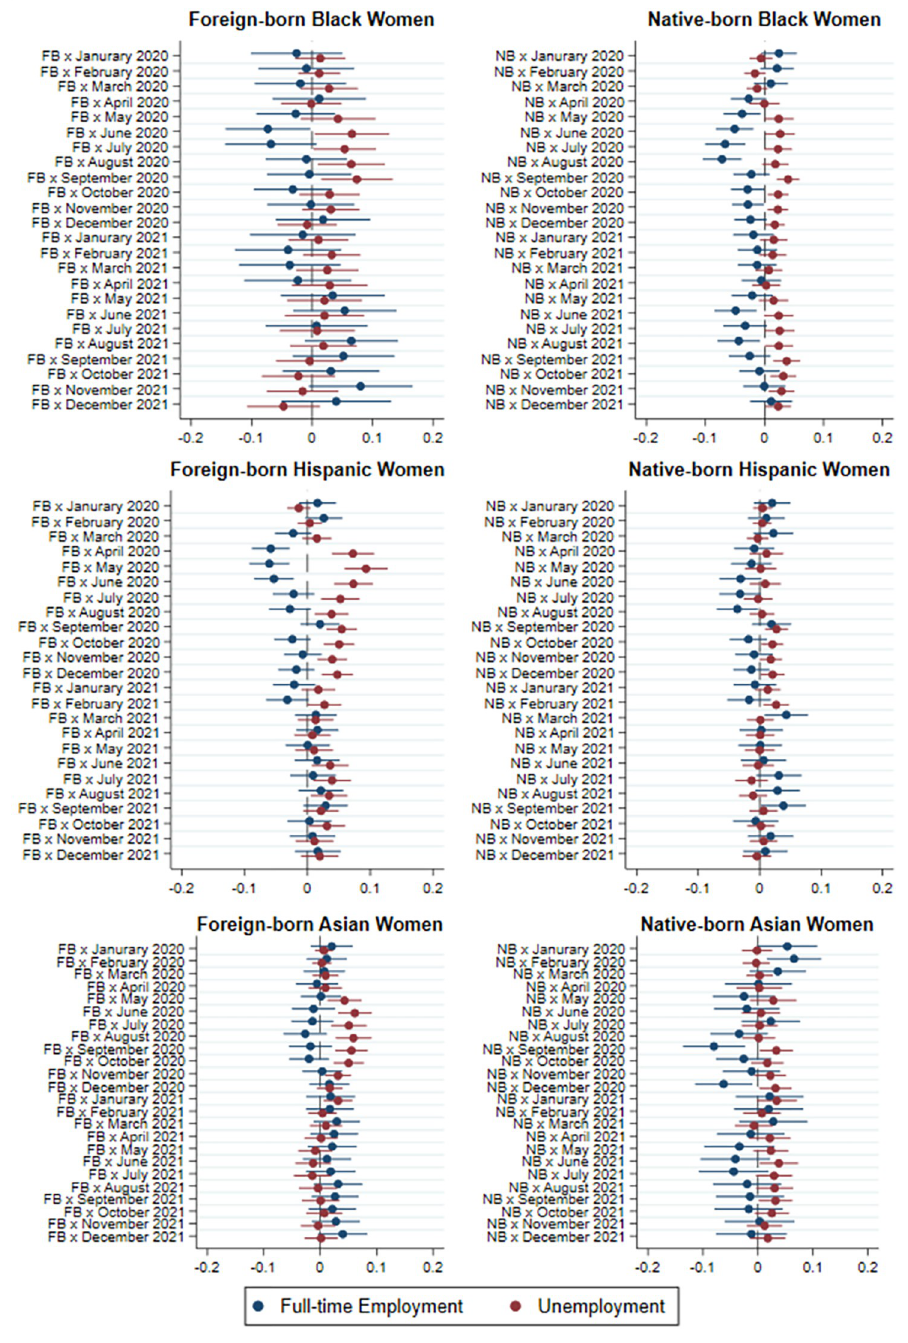
Fig 4. Difference in probability of full-time employment and unemployment between non-White and native-born White women by immigrant status and race/ethnicity, 2020–2021 relative to 2019. coefficients reflect the change in the probability of full-time employment for immigrant and non-immigrant women by race/ethnicity, respectively compared to native-born White women.